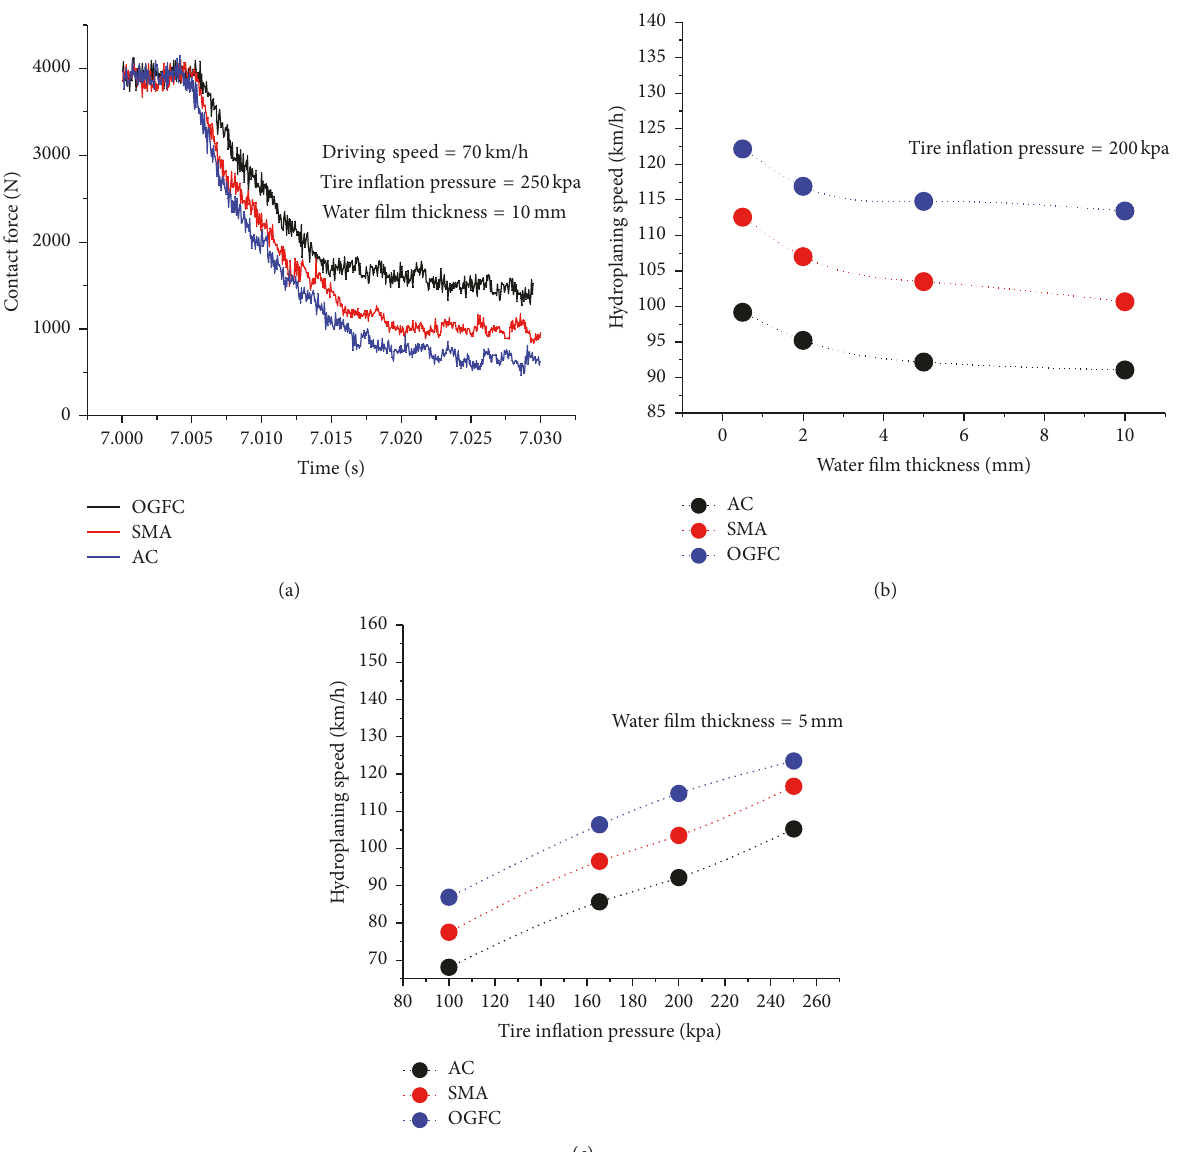
Figure 15: Contact force and hydroplaning speed influenced by pavement types: (a) contact force; (b) hydroplaning speed versus water film thickness; (c) hydroplaning speed versus tire inflation